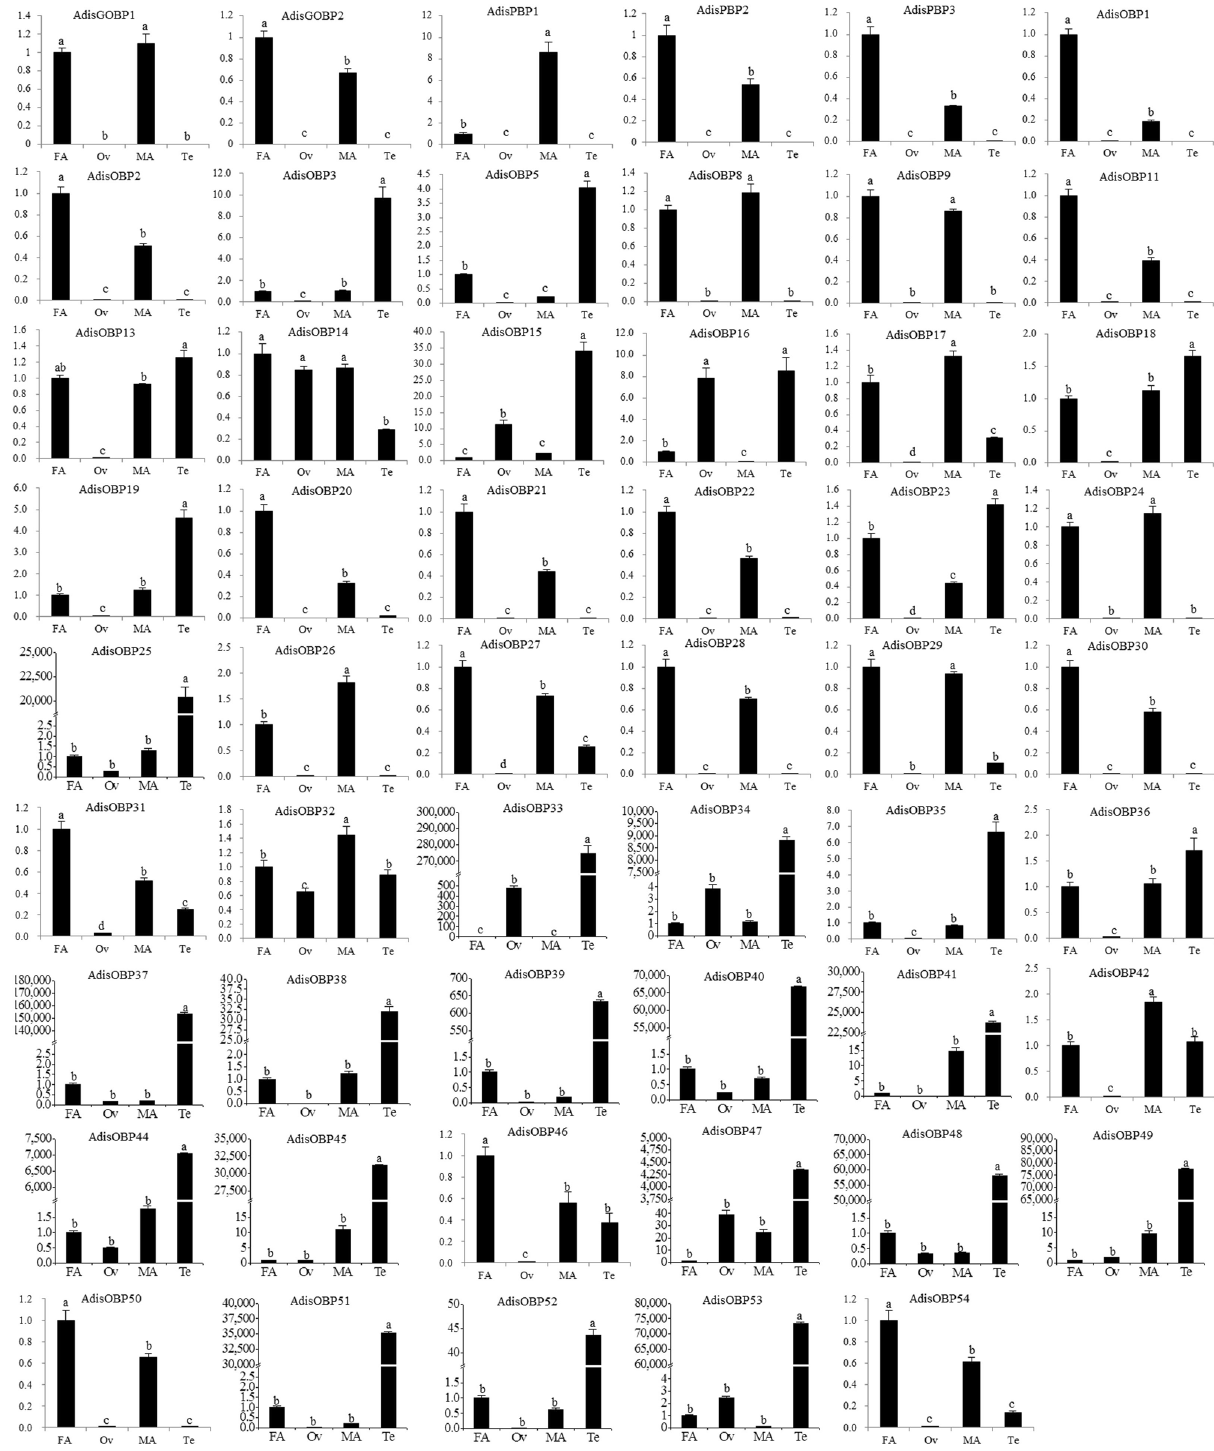
Figure 6. Expression profiles of the candidate OBPs in different tissues of Athetis dissimilis. FA female antennae, MA male antennae, Ov ovaries, Te testis. The standard errors are represented by the error bars; different lowercase letters ( a–c ) above the bars denote significant differences at p ˂